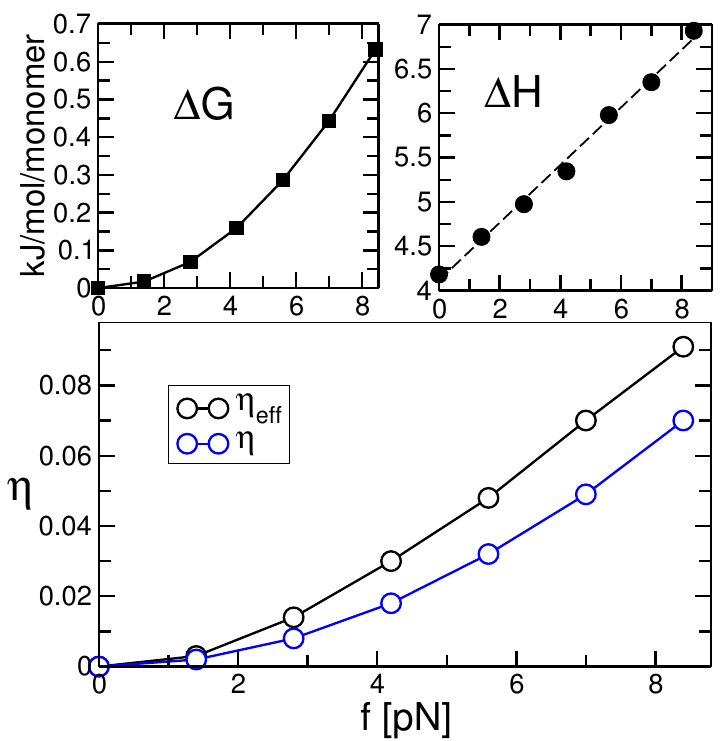
Figure 8. Gibbs free energy of stretching (left upper plot) and enthalpy of fusion (right upper plot) as a function of force in pN . The ratio, η , between the free energy of stretching and the heat of fusion, see Equation (2), as well as the effective ratio, η ef f , using the value of H f for the given force, are shown in the lower